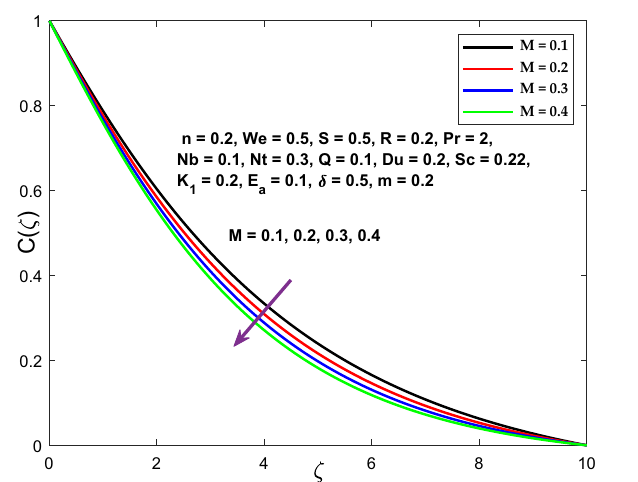
Figure 5. Character of M versus C (ζ) .